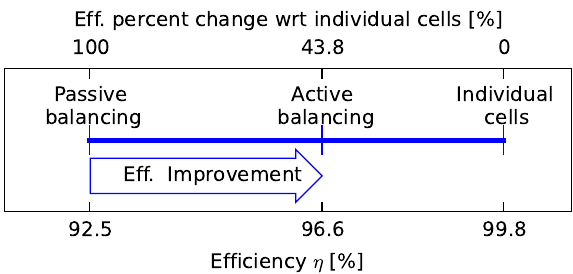
Figure 20. Efficiency of passive balancing, active balancing, and individual